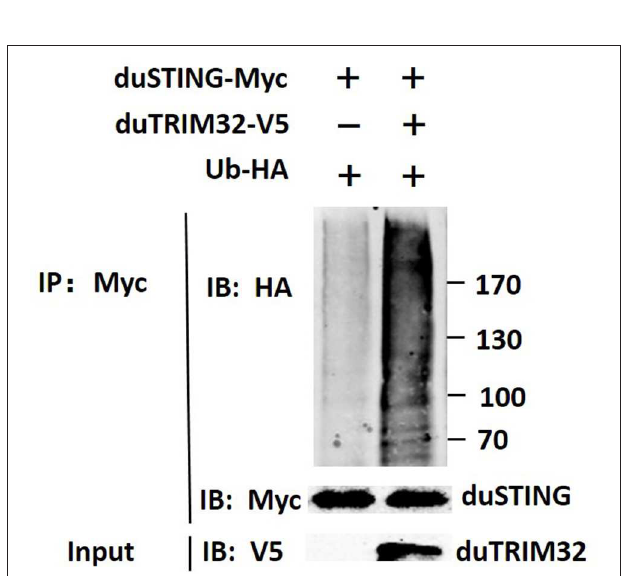
FIGURE 9 | Ubiquitination of duSTING by duTRIM32. The 293T cells were co-transfected with duSTING-Myc, Ub-HA, and duTRIM32-V5. The duSTING-Myc and Ub-HA transfected group was used as a control group. Cell lysates were immunoprecipitated with anti-Myc mAb, in conjunction with protein G Agarose beads (ThermoFisher Scientific, USA) and the immunoprecipitates were analyzed by Western blot.